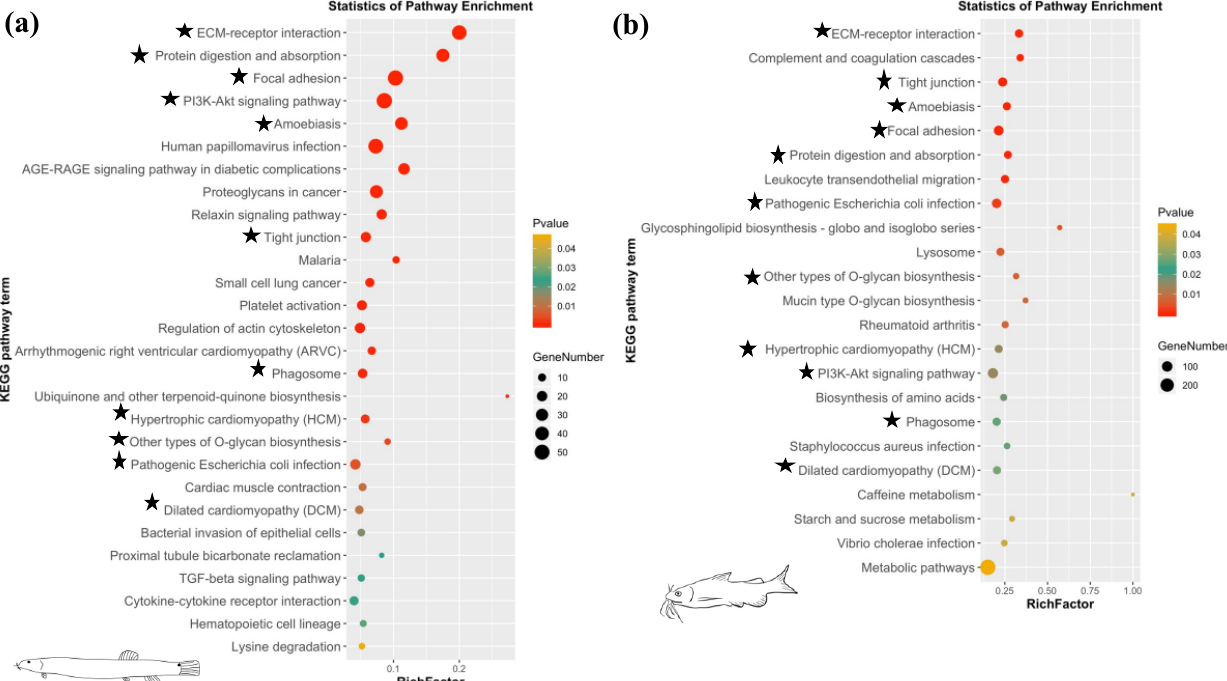
Figure 4. Enrichment of KEGG pathways of differentially expressed genes (DEGs) in the comparisons of RS/OS pertain to loach ( a ) and yellow catfish ( b ). RS: regenerated skins; OS: original skins. Black stars indicate common enriched KEGG pathways between loach and yellow catfish.